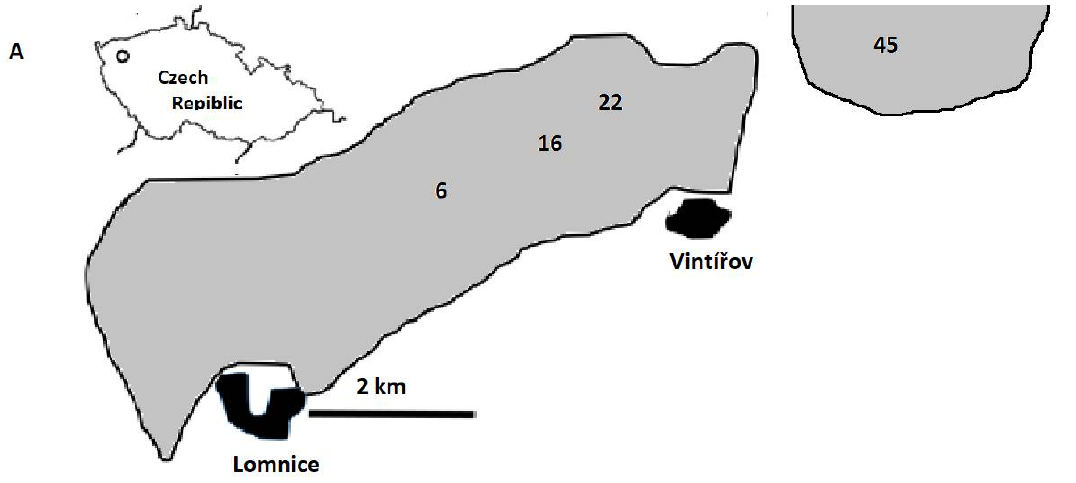
Figure 1. Location of the study site; the gray area indicates the heap and numbers mark the location’s age. Inserted figure in left corner show position of study sites in the Czech Republic.